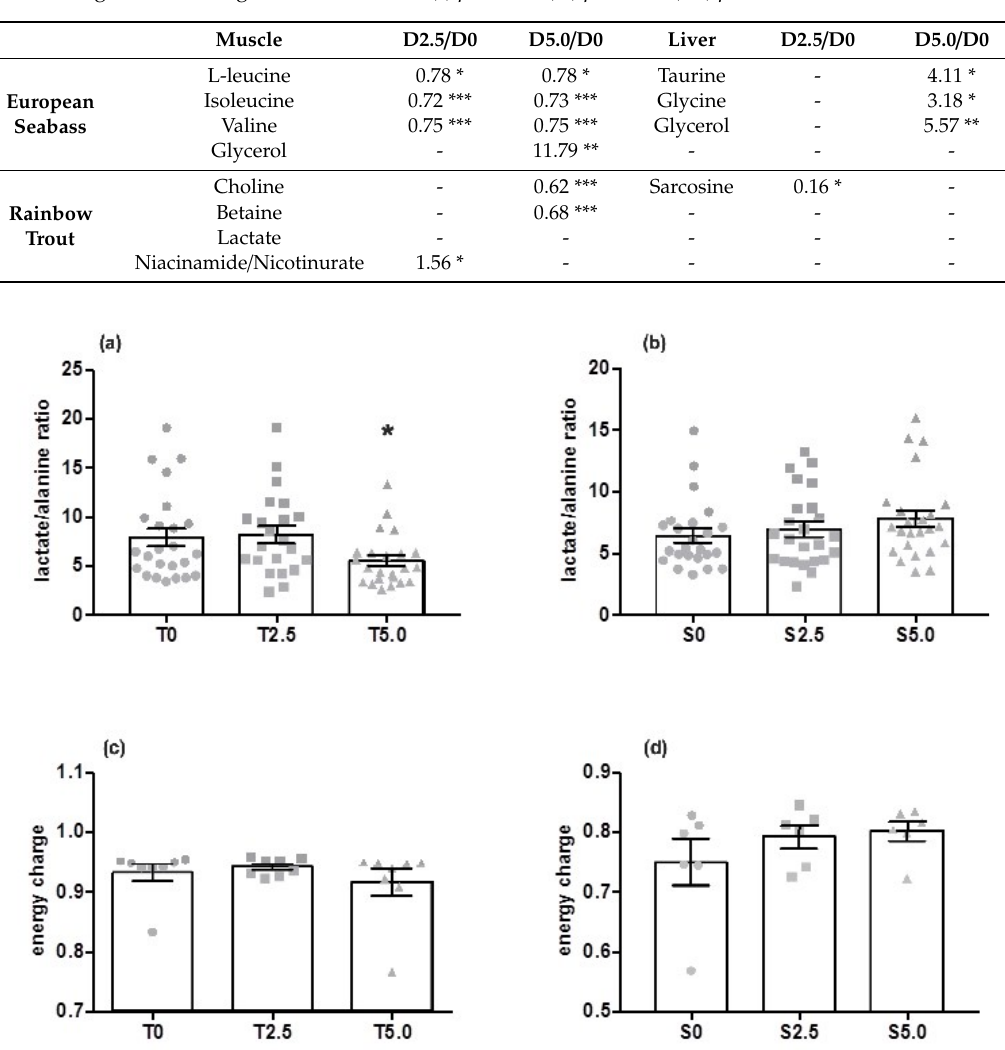
Figure 3. Mean values ( ± SEM) of the lactate / alanine ratio in the muscle aqueous fraction of ( a ) rainbow trout (T0: n = 22, T2.5: n = 22, T5.0: n = 23), and ( b ) European seabass (S0: n = 24, S2.5: n = 24, S5.0: n = 23); and energy charge in muscle of ( c ) rainbow trout ( n = 8 per diet) and ( d ) European seabass ( n = 6 per diet), fed three experimental diets (T0: 0% glycerol, T2: 2.5%, T5: 5.0% glycerol). Key: (*) p <